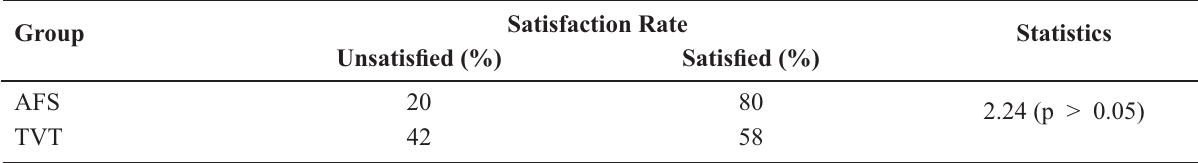
Table 3 – Satisfaction rate of autologous fascial sling (AFS) and tension-free vaginal tape (TVT) at 36-month follow up. Group